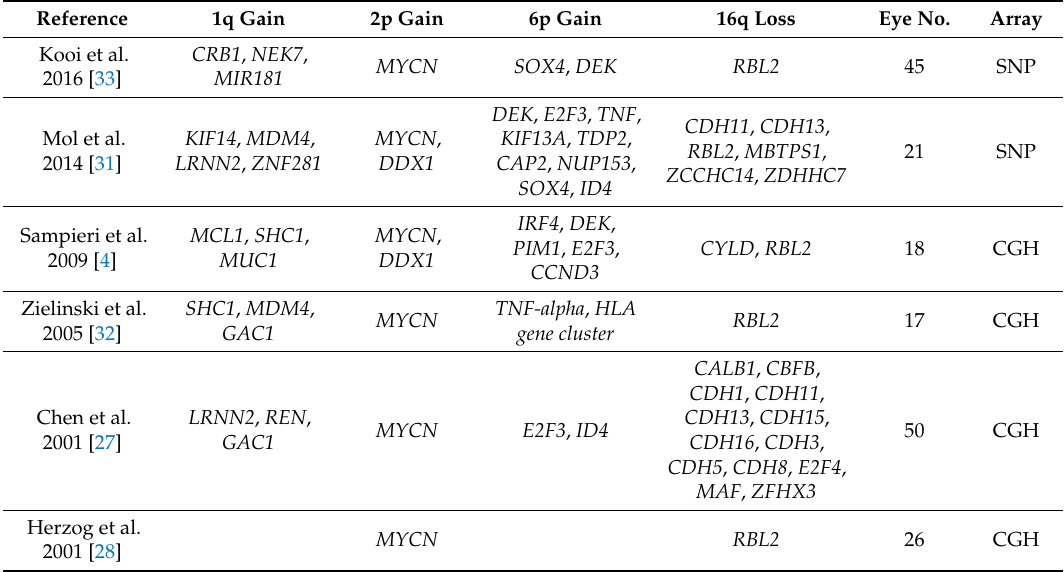
Table 1. Candidate drivers defined in a minimal region using